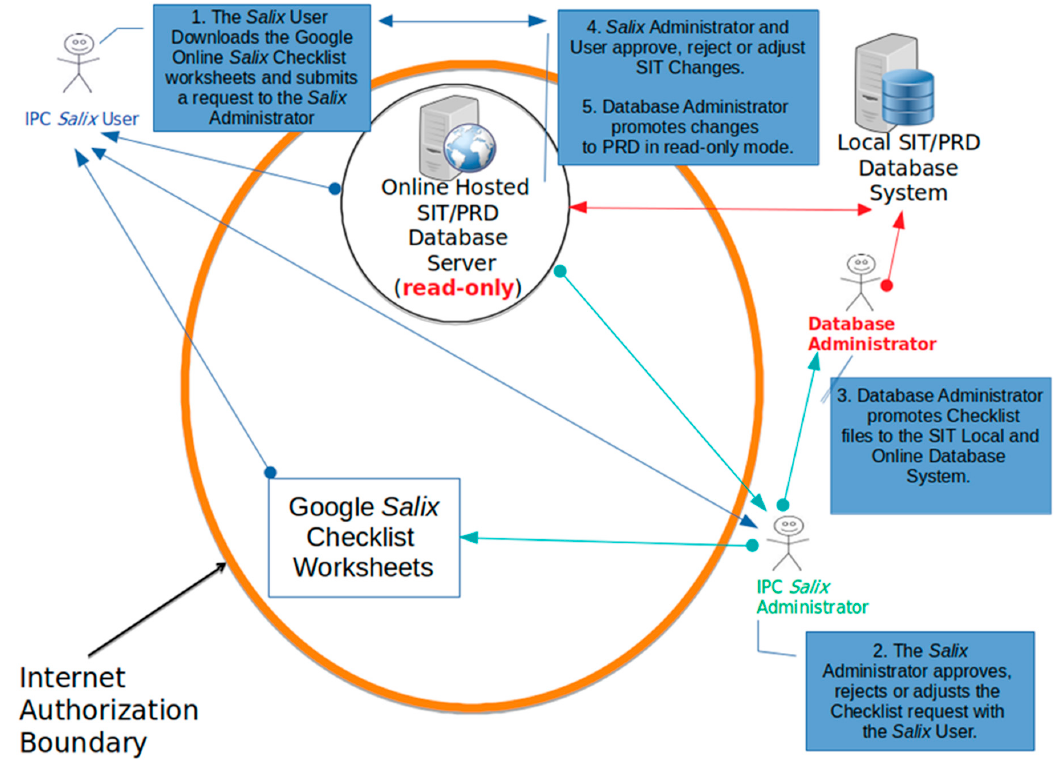
Figure 3. Salix Checklist use case flow diagram.